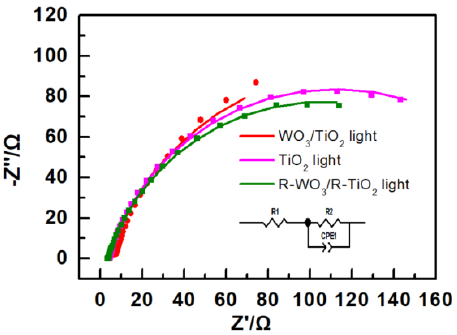
Figure 9. EIS of TiO 2 /CC, WO 3 /TiO 2 /CC, and R-WO 3 /R-TiO 2 /CC materials under sunlight irradia-